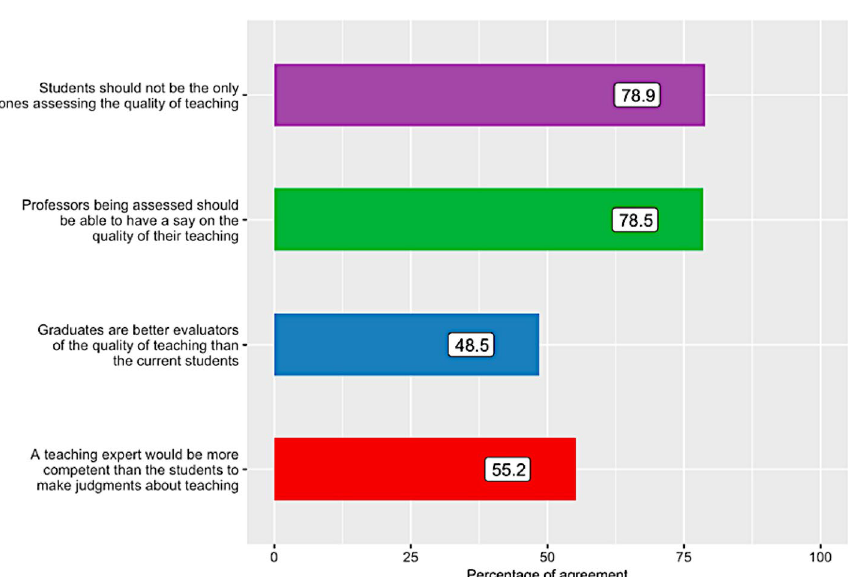
Fig. 2 Percentage of respond‑ ents who say they "somewhat agree or strongly agree" about the sources of